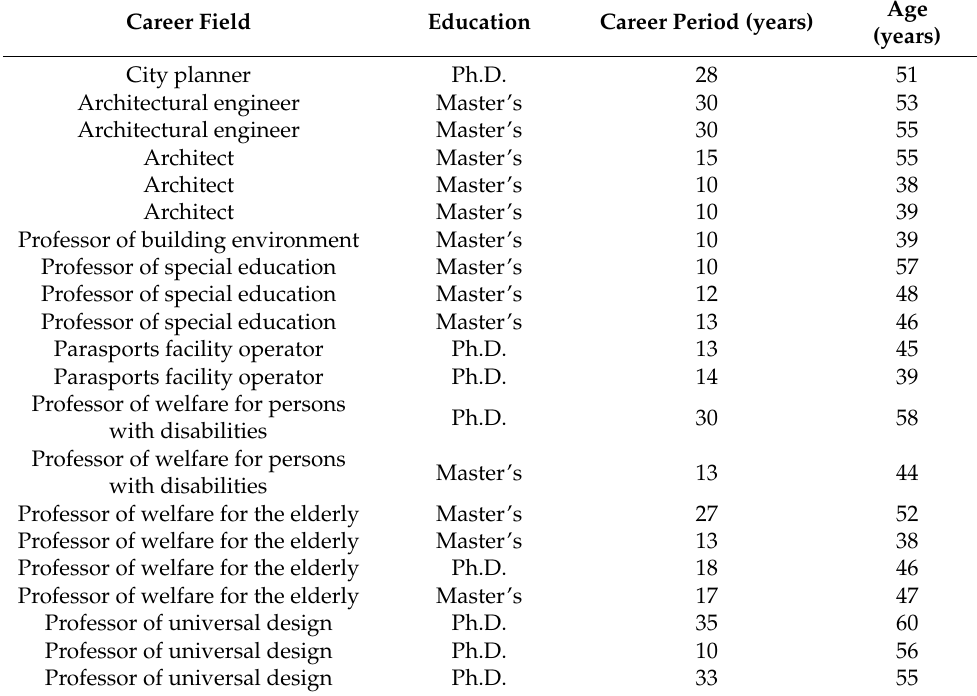
Table 1. Personal characteristics of the expert